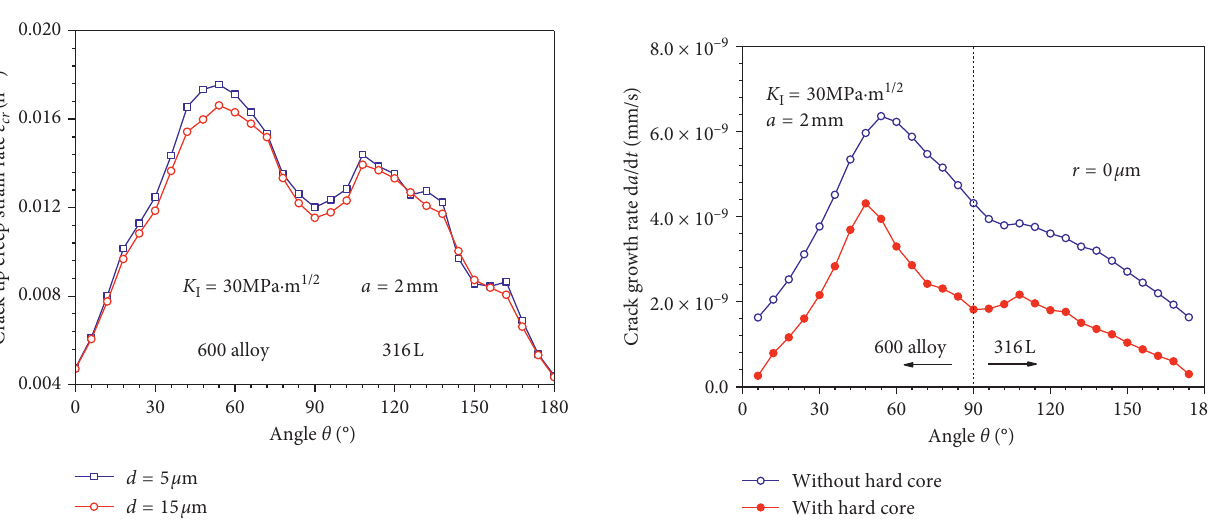
Figure 13: Comparison of the crack growth rate between the crack tip with and without